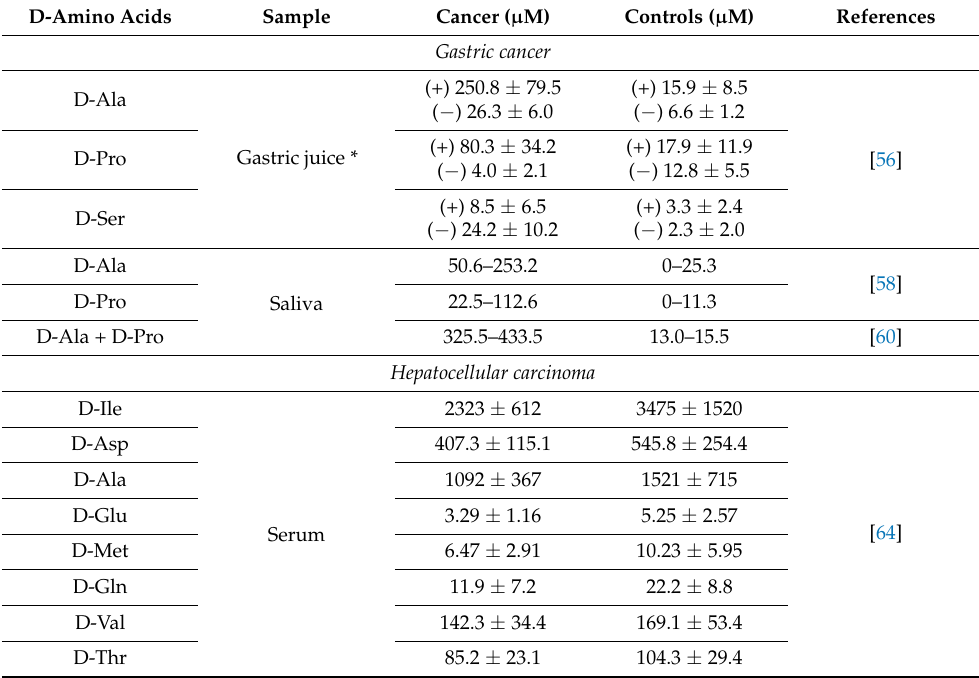
Table 1. D-amino acid concentration in different samples of cancer patients and healthy